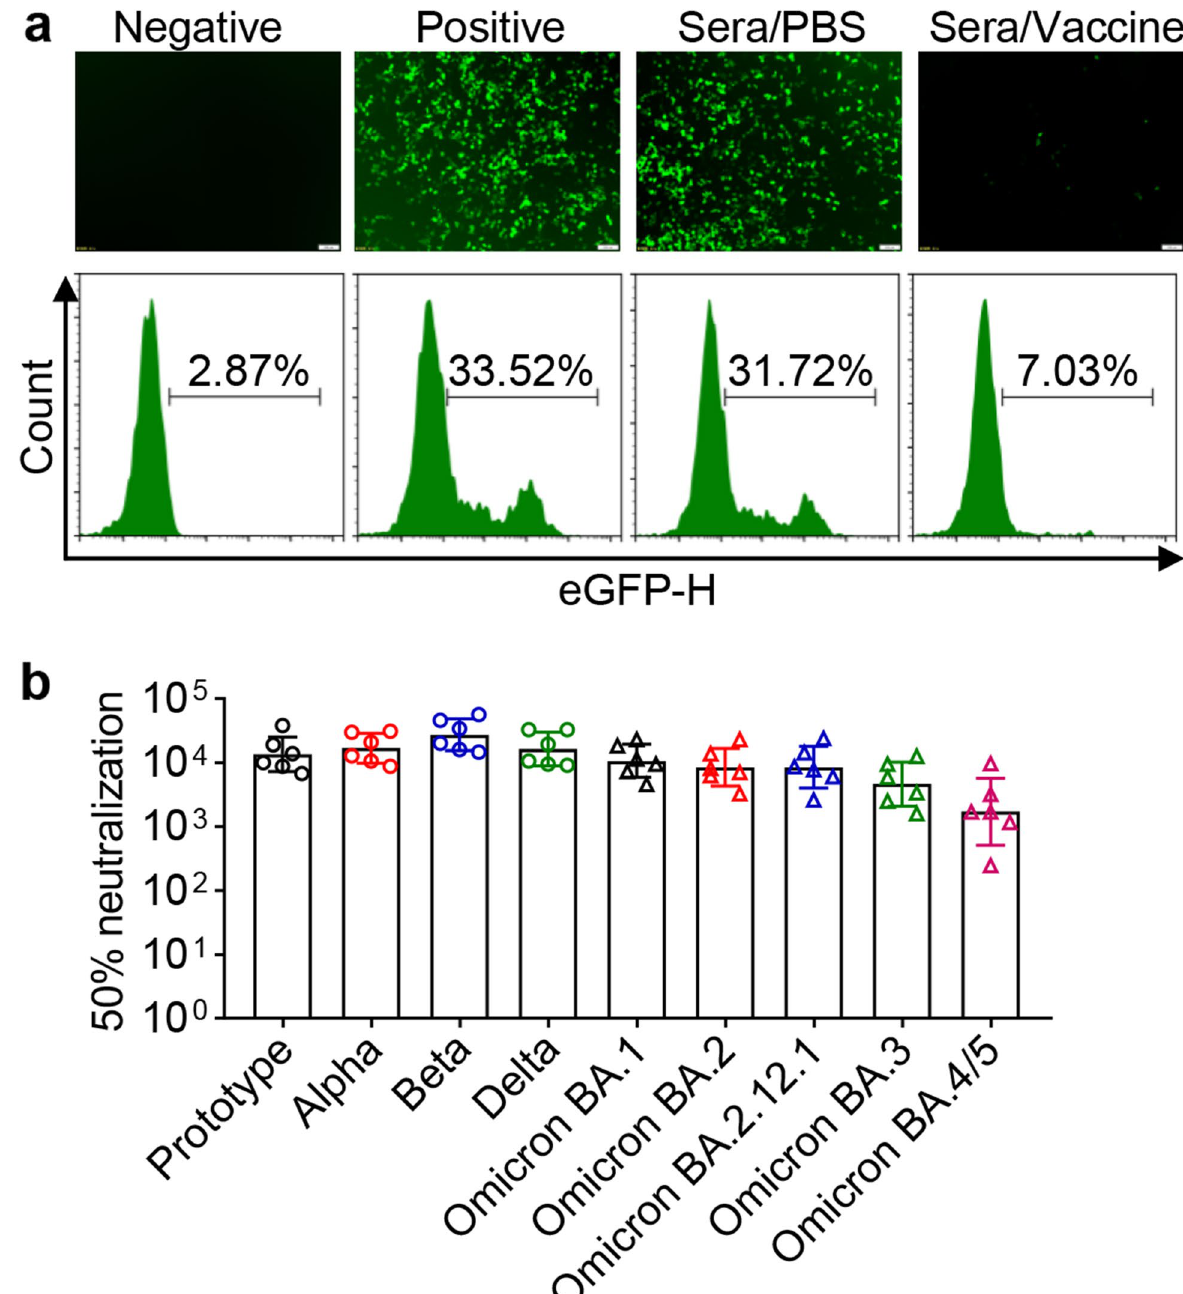
Fig. 4 Neutralization of SARS-CoV-2 pseudovirus infection in 293 T/hACE2 cells by immune sera. a Representative graphs followed the treatment from the left to right orderly: infection without SARS-CoV-2 pseudovirus (negative control); infection with SARS-CoV-2 pseudovirus without sera (positive control); sera from mice treated with PBS (sera/PBS); sera obtained from mice on day 56 treated with the vaccine at 1:90 dilution (sera/ vaccine). b Neutralizing antibody titers of the immunized sera on day 56 against the pseudoviruses bearing either prototype, Alpha, Beta, Delta, Omicron lineages BA.1, BA.2, BA.2.12.1, BA.3, BA.4/5. Data are geometric mean ±